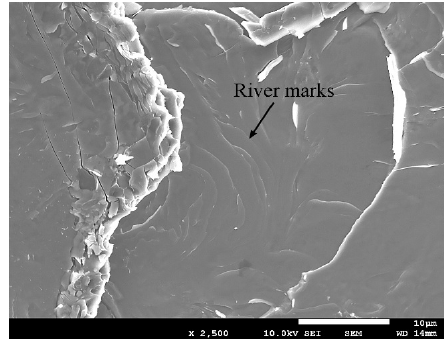
Figure 8. The images show opposite fracture surfaces where ( a , c ) shows cleaved β‐ particles and ductile fracture of dendrites through the platelet. Image ( b , d ) shows a cleaved sludge particle.